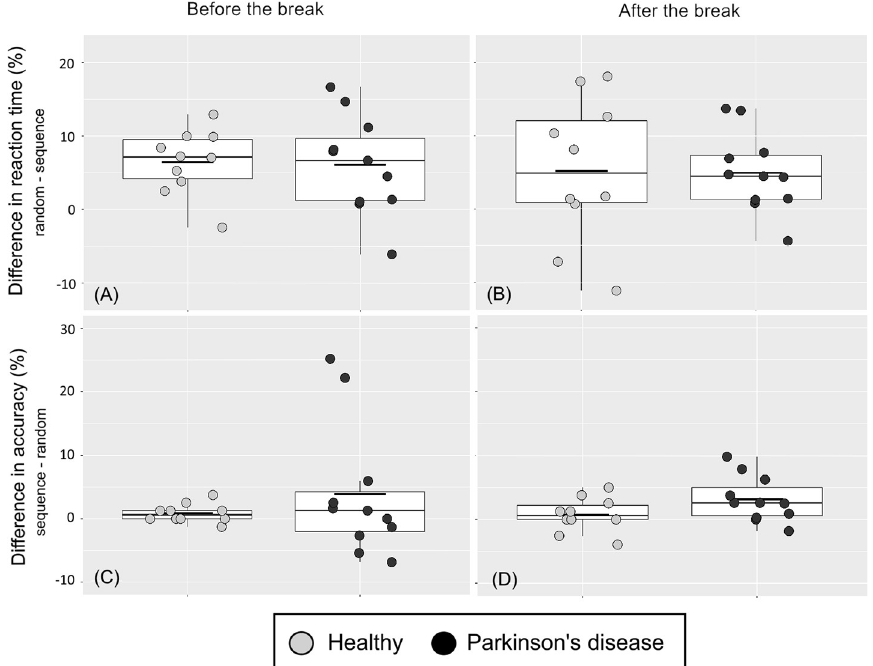
Fig 2. Implicit sequence learning outcomes of the SRTT on the group and individual level. (A) and (B): A value above zero indicates implicit sequence learning as measured by lower RTs for the last two sequence blocks compared to the last two random blocksbefore (left) and after (right) the break. (C) and (D): A value above zero indicates implicit sequence learning as measured by higher accuracy for the last two sequence blocks than for the for last two random blocks before (left) and after (right) the break. Each boxplot shows the median (the thin line), the mean (the short bold line), the 25th and 75th percentiles (the hinges), and the range from the smallest to the largest value if not exceeding 1.5 times the interquartile range (the